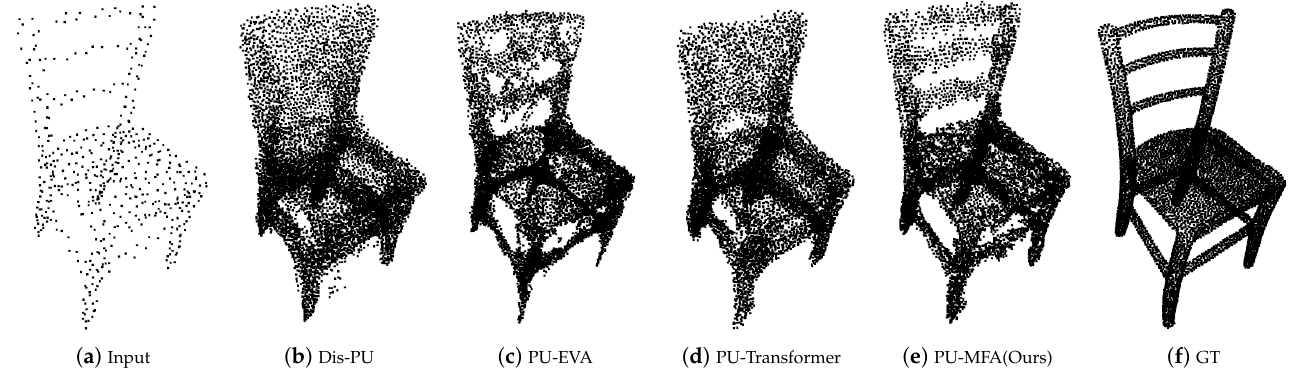
Figure 7. Visualization result of × 16 up-sampling of PU-GAN